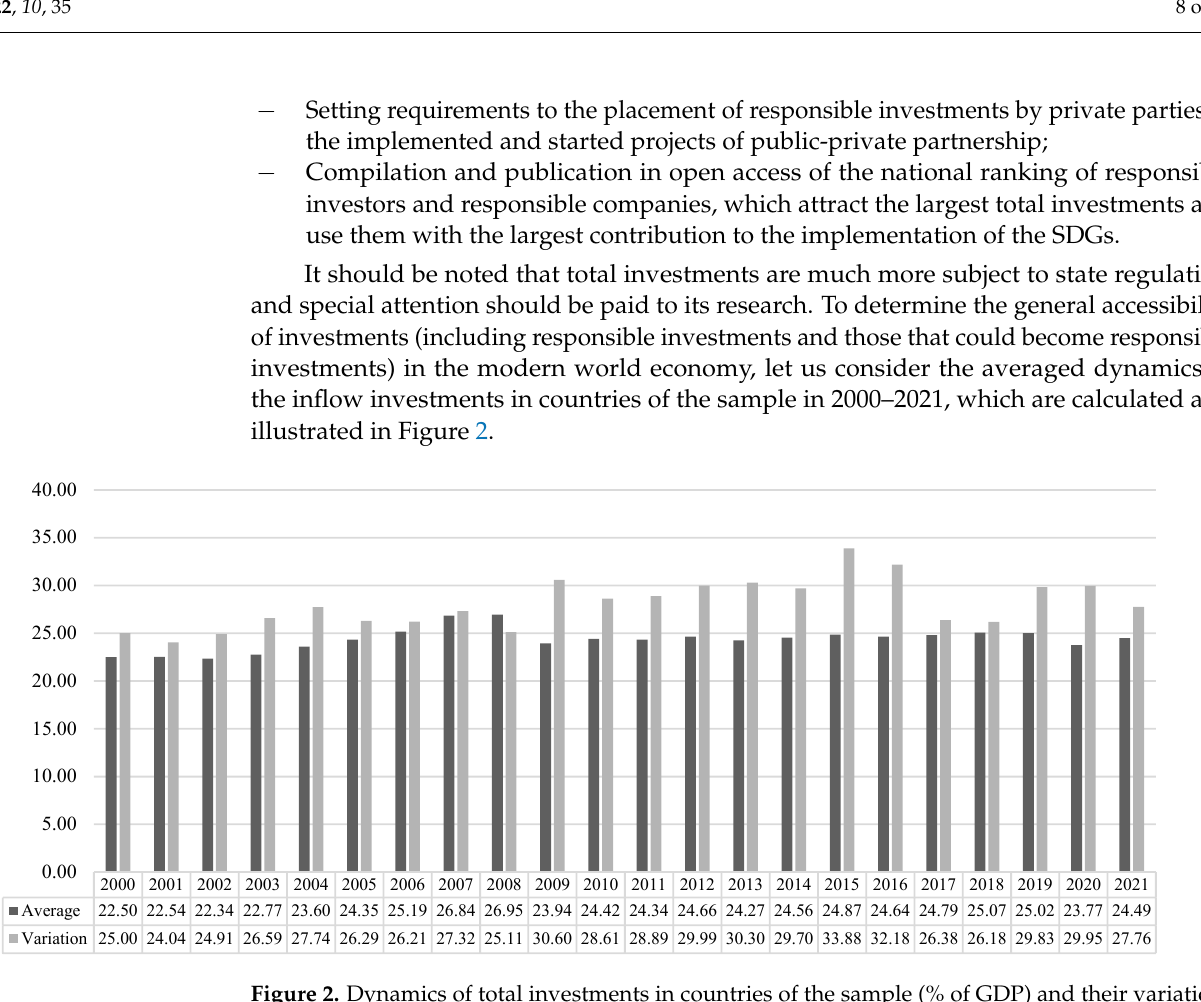
Figure 2. Dynamics of total investments in countries of the sample (% of GDP) and their variations (%) in 2000–2021. Source: Calculated by the authors based on (Vagin et al. 2021).